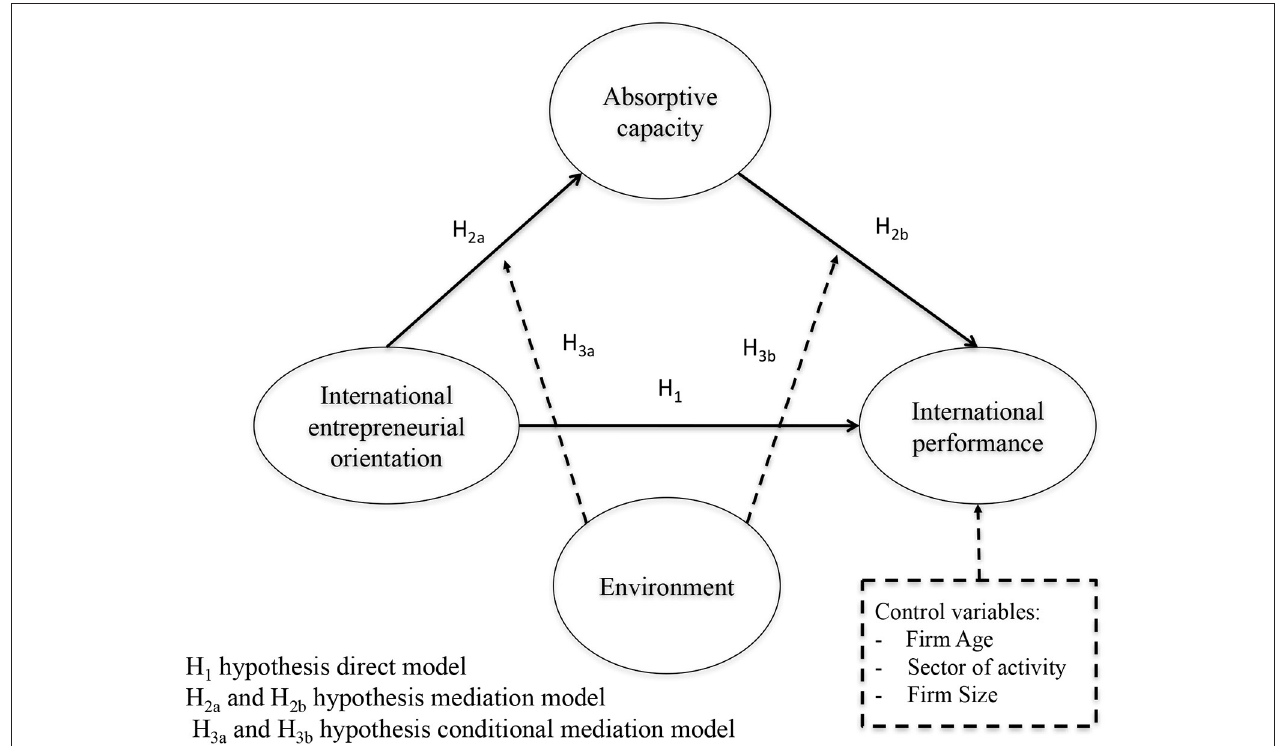
FIGURE 1 | Structural